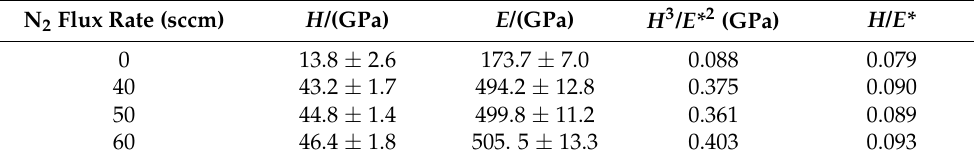
Table 4. Mechanical properties of the TiAlN coatings deposited at different nitrogen flux rates. N 2 Flux Rate (sccm)